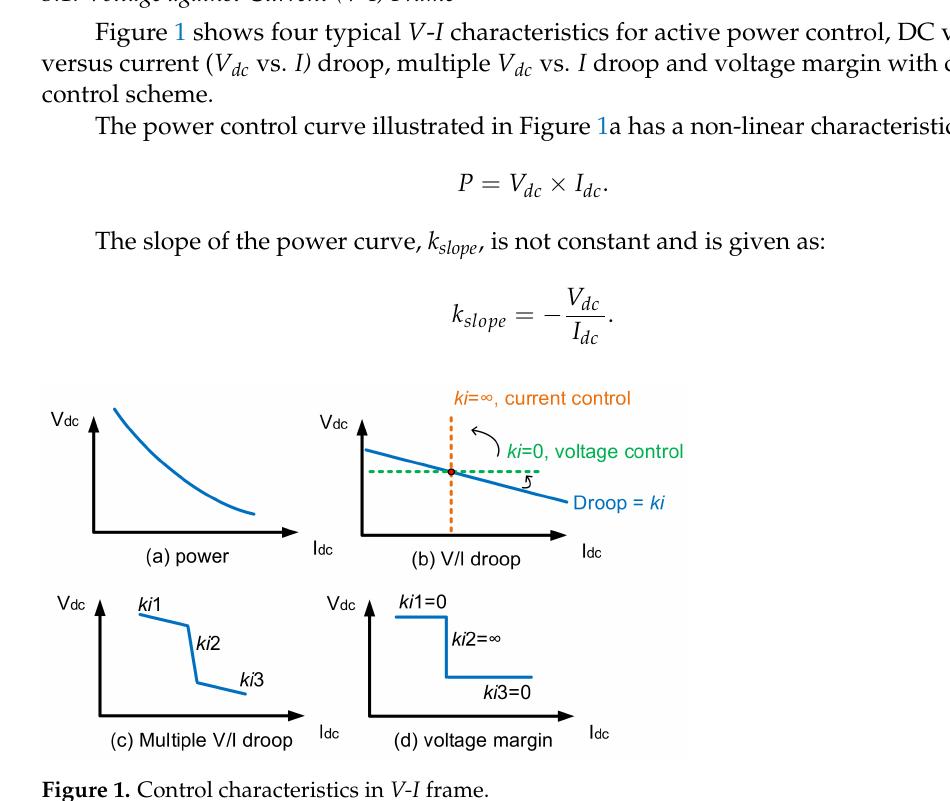
Figure 1. Control characteristics in V-I